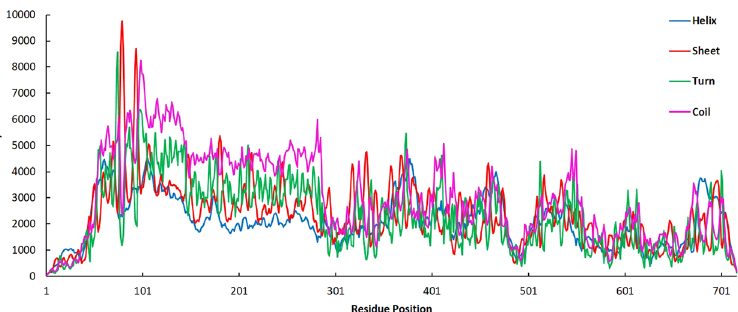
Figure 1. The probability graph of occurrence of helix, sheet, turn and coil in the secondary structure of the antigenic lipoprotein Q75FL0 of LIC. Here, the graph indicates the values of probability for each secondary structure at all amino acid positions of the